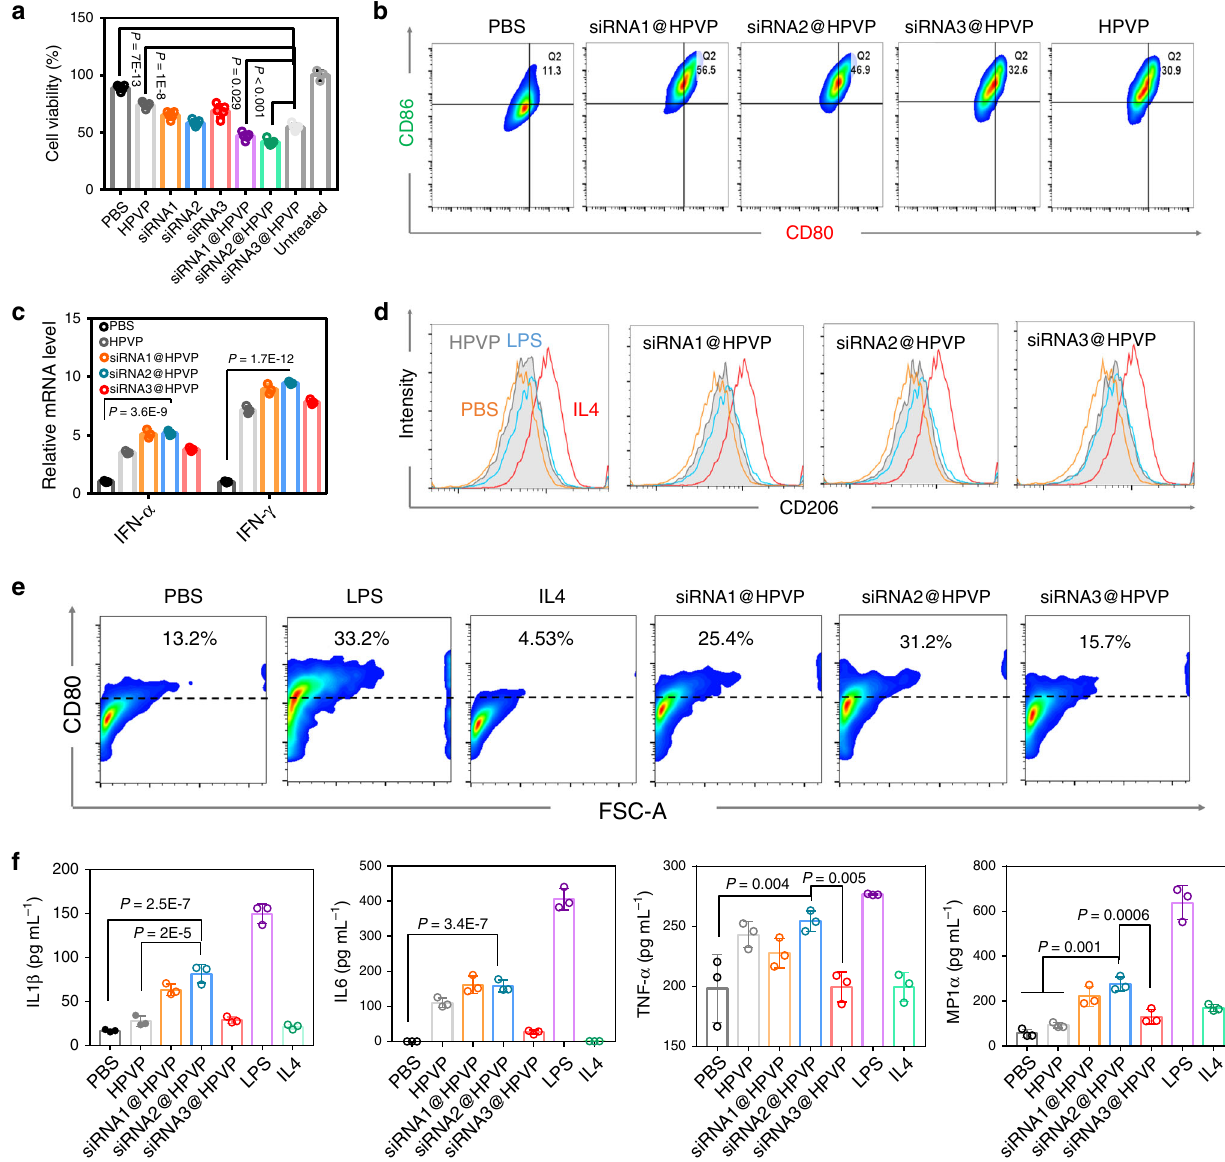
Fig. 2 In vitro APCs activation. a In vitro cytotoxicity of splenocytes towards 4T1 cells (with the effector/target ratio of 10:1). Splenocytes were pretreated with different samples (PBS, HPVP, siRNA1, siRNA2, siRNA3, siRNA1@HPVP, siRNA2@HPVP, or siRNA3@HPVP) for 24 h before the cytotoxicity assay. Five biological replicates are shown. b FACS data of the mature DCs (CD80 + CD86 + ) gating on CD11c + cells after co-incubated with different siRNA@HPVP formats (siRNA1@HPVP, siRNA2@HPVP, or siRNA3@HPVP), HPVP or fresh culture medium for 24 h. A representative image of